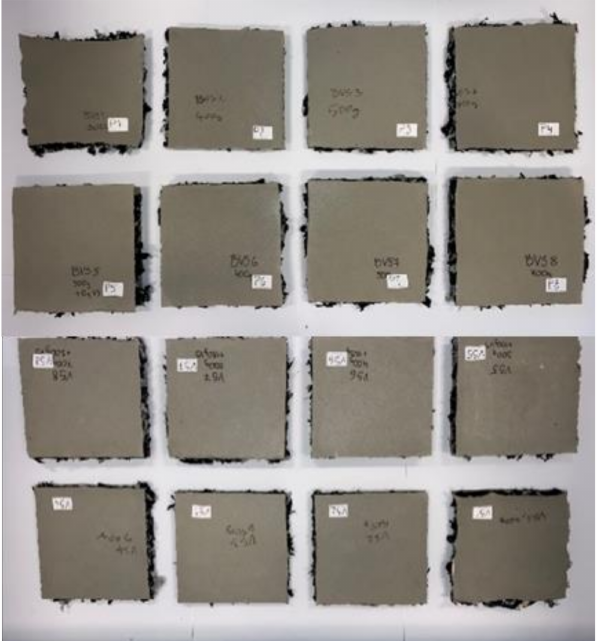
Figure 4. Overview of the produced thermal insulation slab